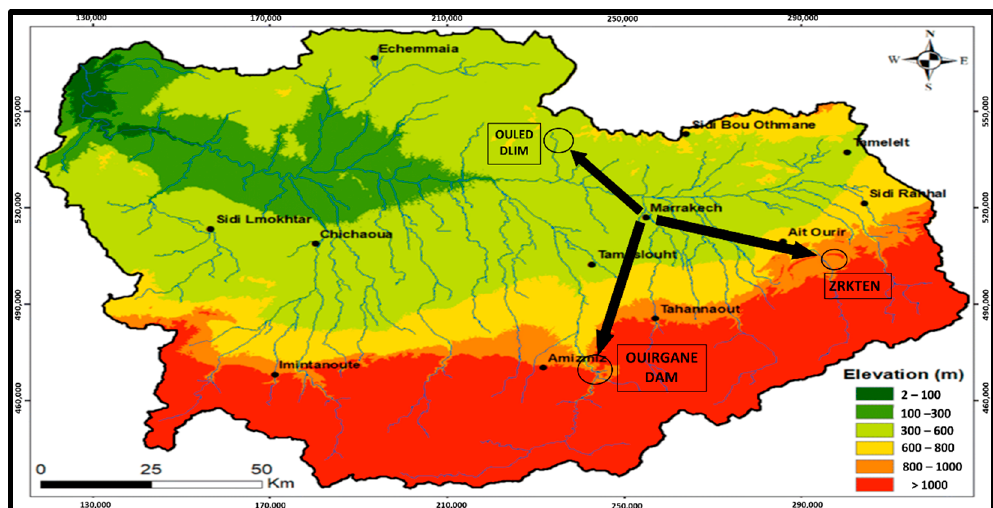
Figure 1. Soils according to Tensift watershed map.